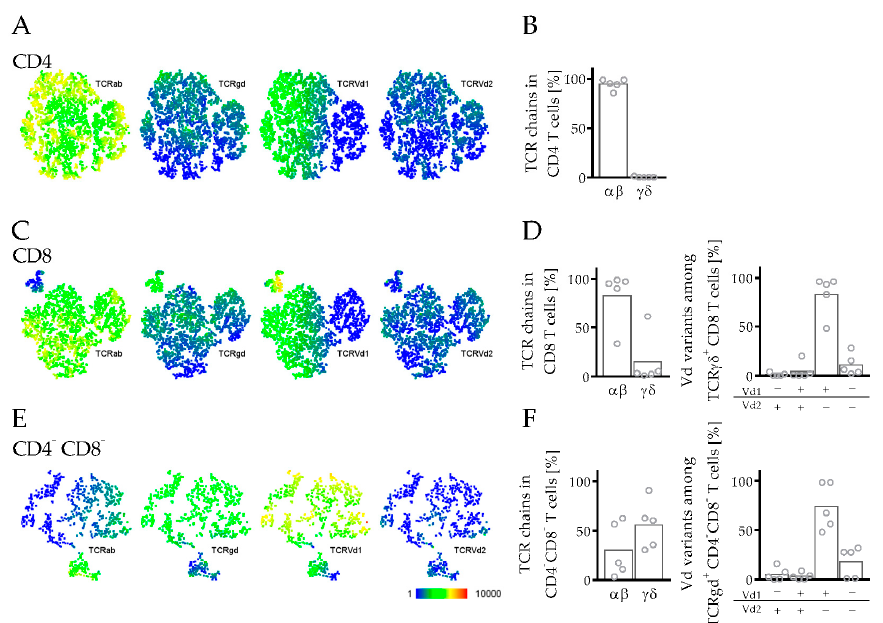
Figure 5. TCR repertoire in T cells in spleens of hPDX. PDX tumors from breast cancer patients were transplanted orthotopically in humanized NSG mice. Splenocytes were analyzed by flow cytometry. ( A ) CD4 T cells (CD3 + CD4 + ), ( C ) CD8 T cells (CD3 + CD8 + ) and ( E ) double-negative T cells (CD3 + CD4 −